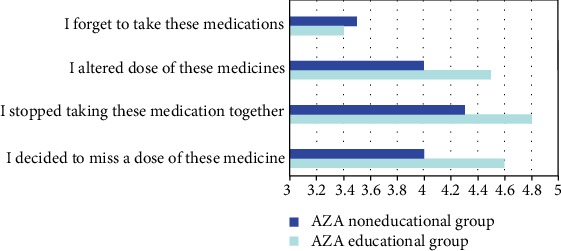
The impact of AZA educational program on different aspects of MARS.